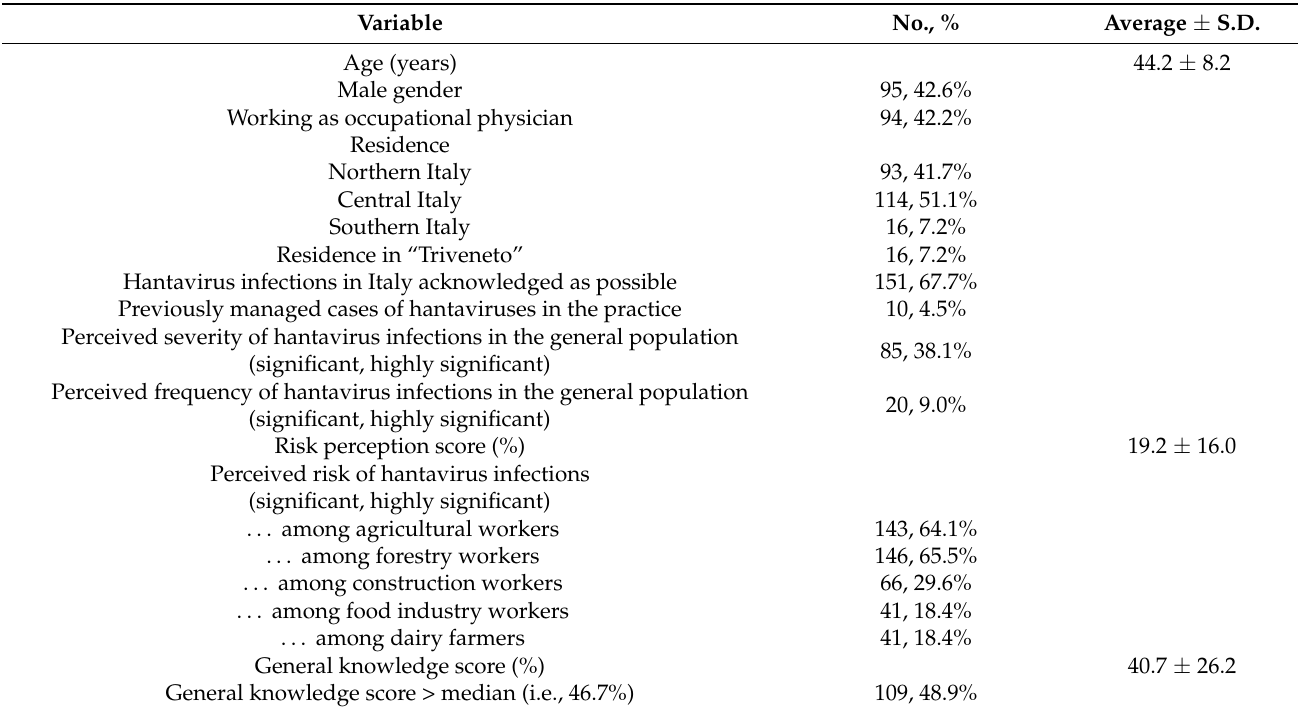
Table 1. Characteristics of 223 Italian physicians participating in the survey (2020). Likert scale for perceived severity and perceived frequency of hantavirus infections were dichotomized as “significant” and “very significant” (i.e., severe and frequently reported disease) vs. all other values (i.e., not severe and infrequently reported).